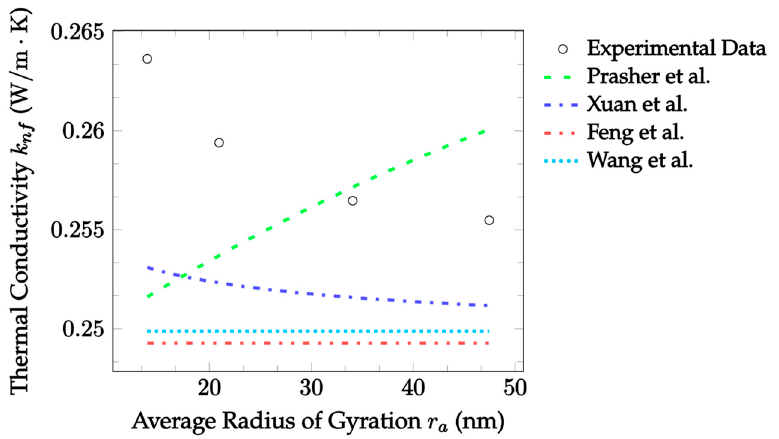
Figure 8. Aggregation model thermal conductivity predictions compared with data for CuO––EG nanofluid: Experimental Data [73], Prasher et al. [29], Xuan et al. [30], Feng et al. [31], Wang et al. [32].